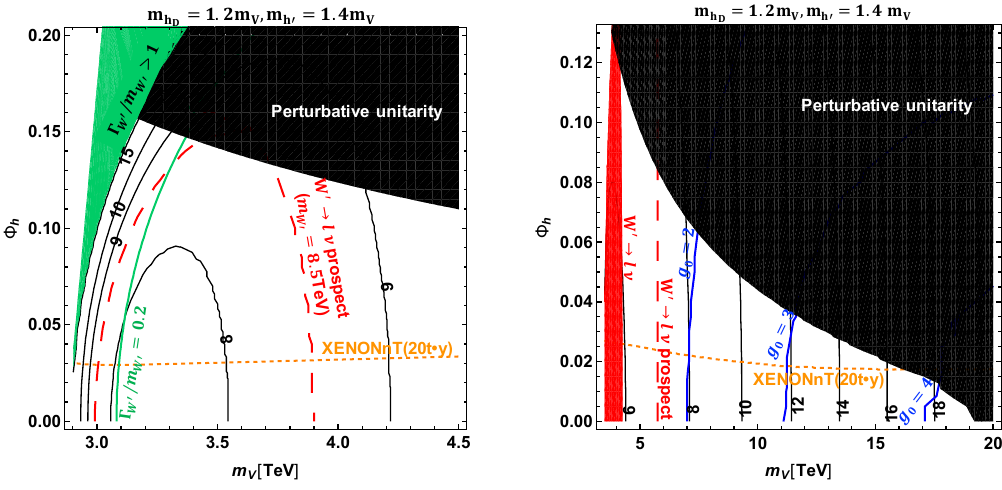
Figure 7 . Combined results in the m V - (cid:30) h plane. The left (right) panel shows the case for m Z 0 > 2 m V ( m Z 0 < 2 m V ). We determine m Z 0 to obtain the right amount of the DM relic abundance, and the values are shown by the black-solid contours in TeV unit. The orange dotted line shows the prospect of XENONnT [56]. The red dashed line shows the prospect of W 0 search [44]. In the left panel, the green line shows the value of (cid:0) W 0 =m W 0 , and (cid:0) W 0 > m W 0 in the green shaded region. The red shaded region in the right panel is already constrained by the W 0 search [42]. The black shaded regions in both panels are excluded by the perturbative unitarity of the scalar quartic couplings. The blue-solid contours in the right panel show the value of g 0